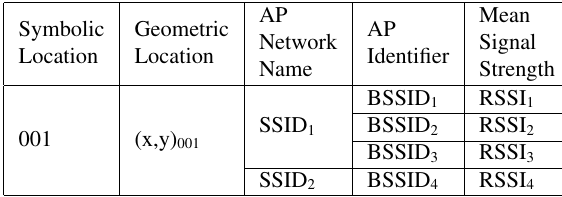
Table 2. Information restructured based on its Symbolic